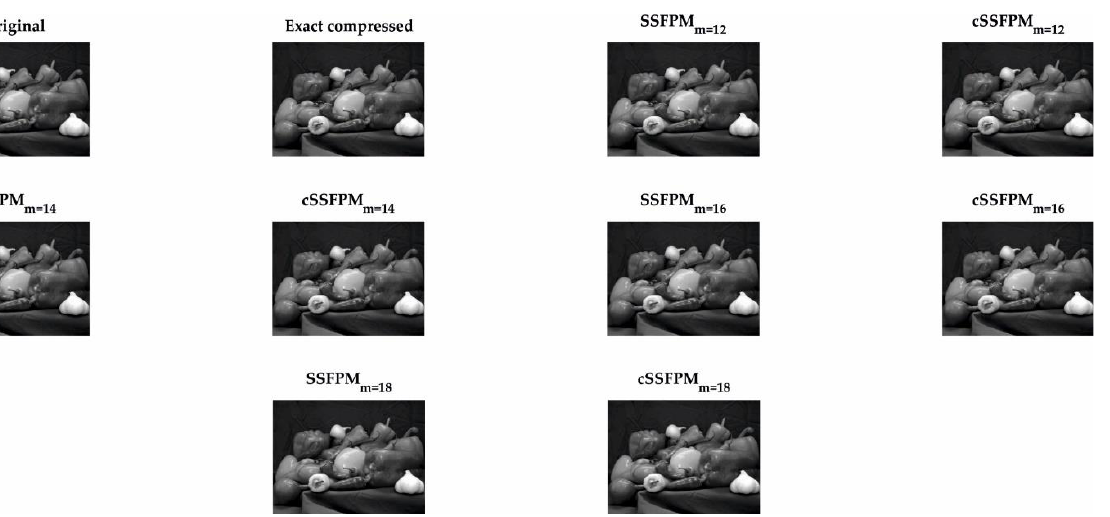
Figure 10. JPEG compressed images with multiplications realized by means of proposed SSFPMs. The quality factor is Q = 40. Table 5. Performances of the proposed SSFPM, cSSFPM and the state-of-the-art in the JPEG com- pression.